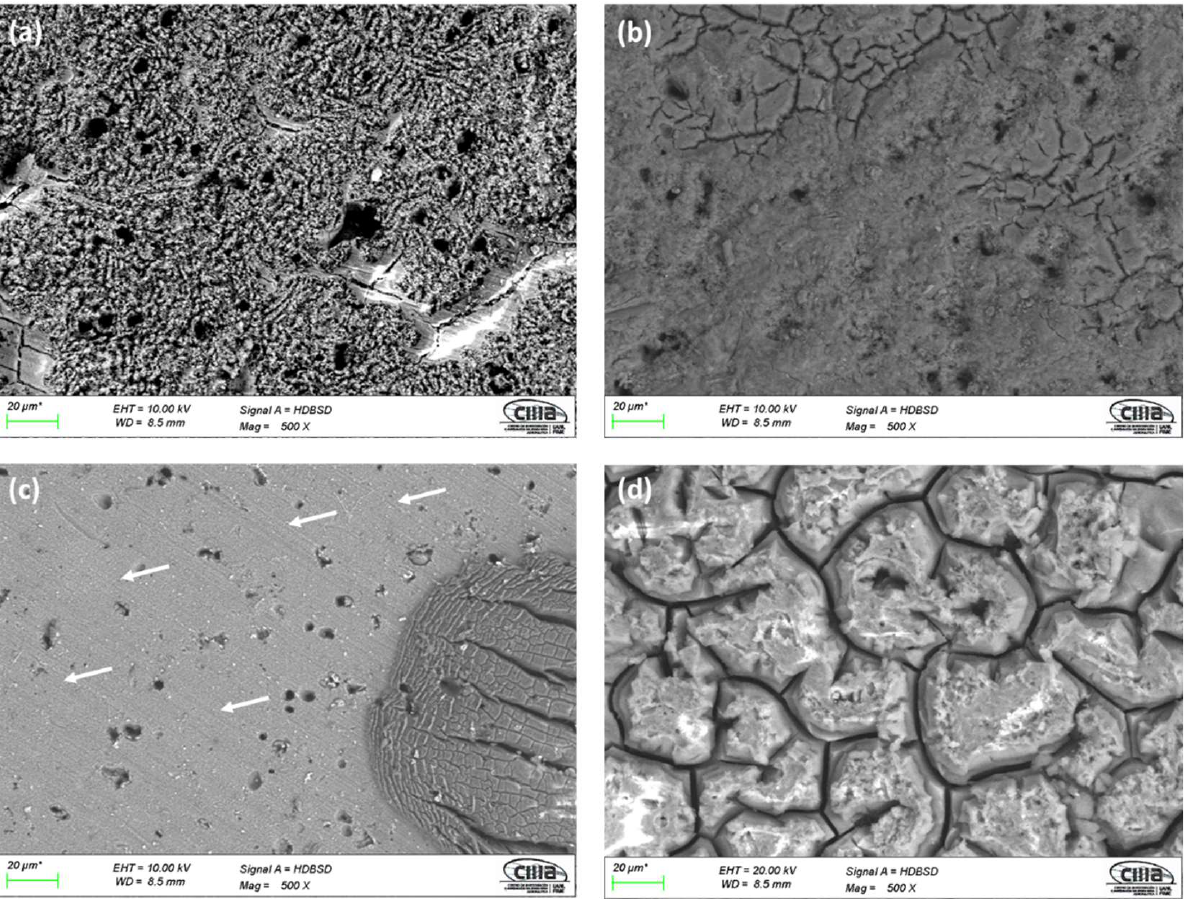
Figure 2. SEM-BSE surface morphology of anodized samples of AA2024 at 4.5 A/dm 2 : ( a ) 4.5A C1M S5, ( b ) 4.5A C1M S10, ( c ) 4.5A C1M, and ( d ) 4.5A S1M.